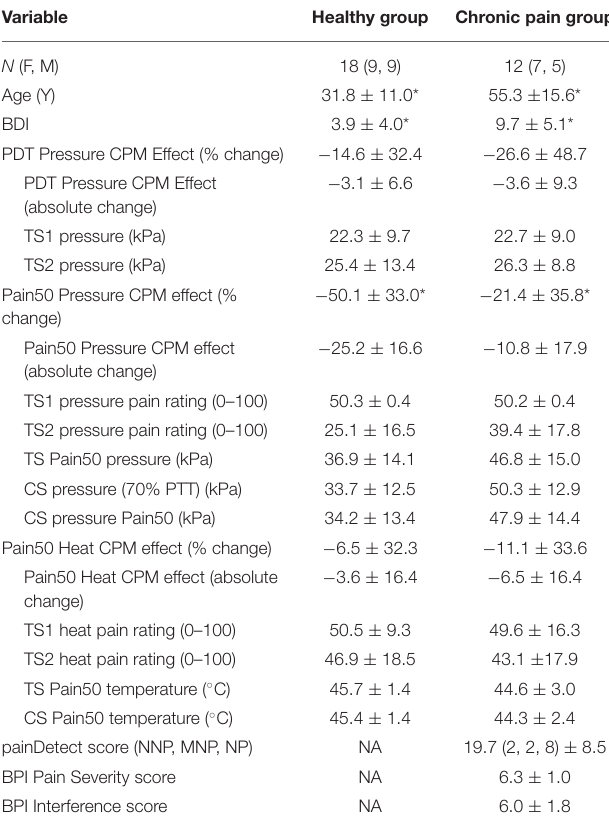
TABLE 1 | Group demographics and CPM descriptive